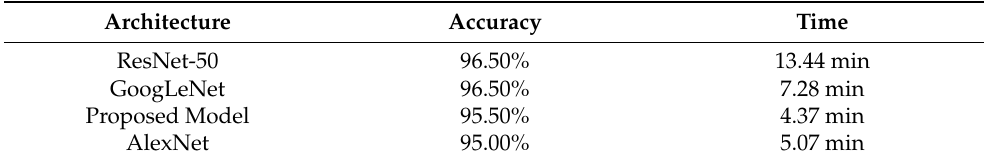
Table 7. Analysis of the R-CNN test results.